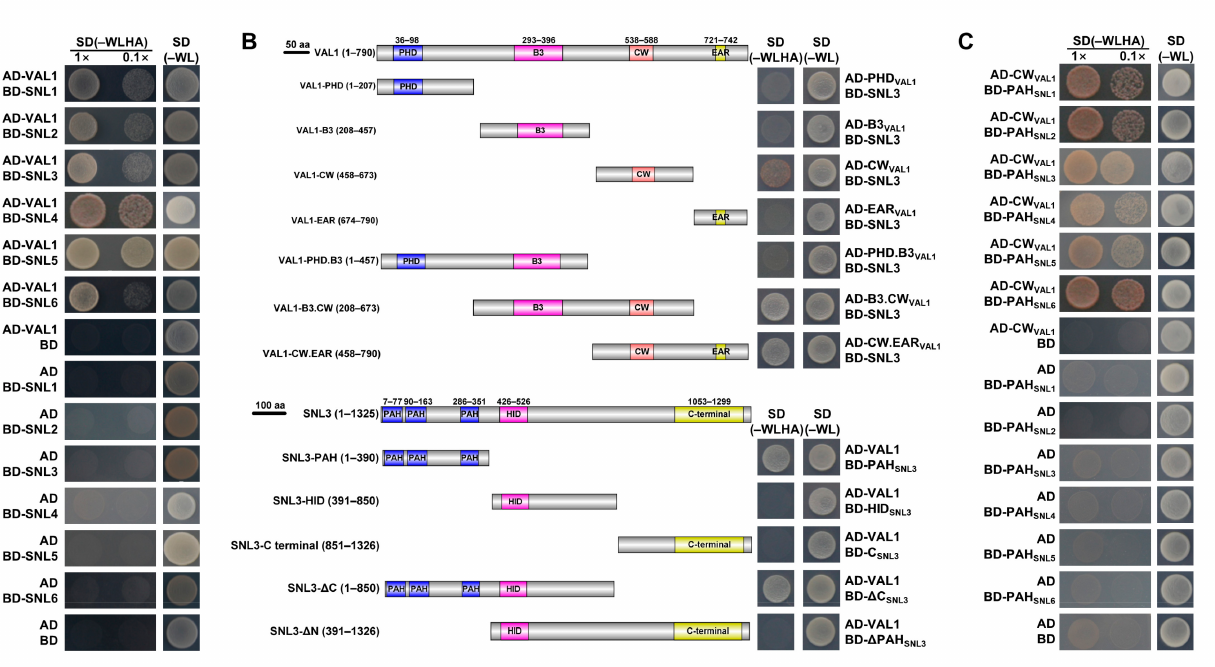
Figure 1. VAL1 interacts with SNLs through the CW domain of VAL1 and the PAH domains of SNLs in yeast cells. ( A ) Intact VAL1 interacts with complete SNLs (SNL1–SNL6) in yeast cells. Full- length of VAL1 and SNLs were fused to the GAL4 activating domain (AD) and binding domain (BD), respectively. The transformed yeast cells were spotted onto a stringent selection medium lacking Trp, Leu, His, and Ade (–WLHA) or a non-selective medium lacking Trp and Leu (–WL; control). ( B ) Schematic presentation of the truncated regions of VAL1 and SNL3, and the CW domain of VAL1 (aa 458–673) and the PAH domain of SNL3 (aa 1–390) were responsible for their interaction. Shown below are the conserved PHD, B3, CW, and EAR domains of VAL1; the PAH and HID domains of SNL3; The VAL1-PHD.B3, VAL1-B3.CW, and VAL1-CW.EAR representing truncated CW and EAR domain, truncated PHD and EAR domain, truncated PHD and B3 domain regions of VAL1, respectively; the SNL3-C, SNL3- ∆ C, and SNL3- ∆ N representing the C-terminal, truncated C-terminal, and truncated N-terminal regions of SNL3, respectively; and the interactions of each truncated fragment of VAL1 and SNL3 with each other’s full-length in yeast cells. The full-length or regions containing different domains of VAL1 and SNL3 were fused to the GAL4 activating domain (AD) and binding domain (BD), respectively. The transformed yeast cells were spotted onto a stringent selection medium lacking Trp, Leu, His, and Ade (–WLHA) or a non-selective medium lacking Trp and Leu (–WL; control). ( C ) The CW domain of VAL1 interacts with the PAH domains of SNLs in yeast cells. The CW domain of VAL1 and the PAH domains of SNLs were fused to the GAL4 activating domain (AD) and binding domain (BD), respectively. The transformed yeast cells were spotted onto a stringent selection medium lacking Trp, Leu, His, and Ade (–WLHA) or a non-selective medium lacking Trp and Leu (–WL;